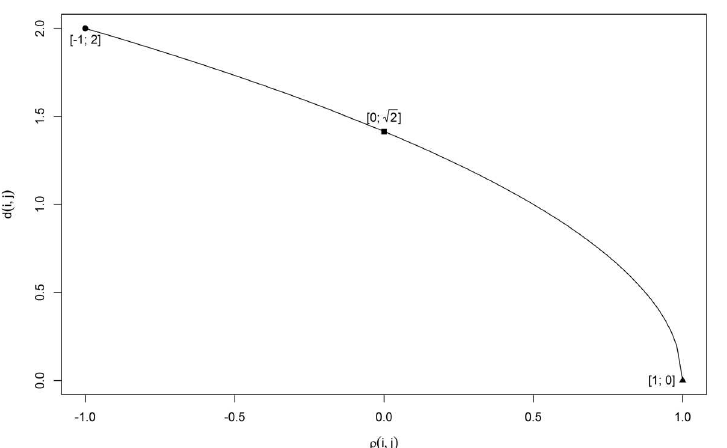
Figure 1. Negative dependence between distance and